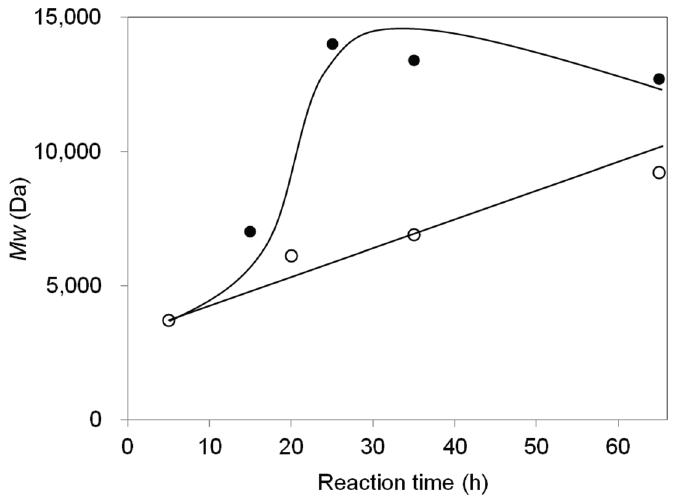
Figure 2. Changes in the molecular weight of the PLA–PEG copolymers as a function of the reaction time at 150 ( ○ ) and 180 °C ( ● ).